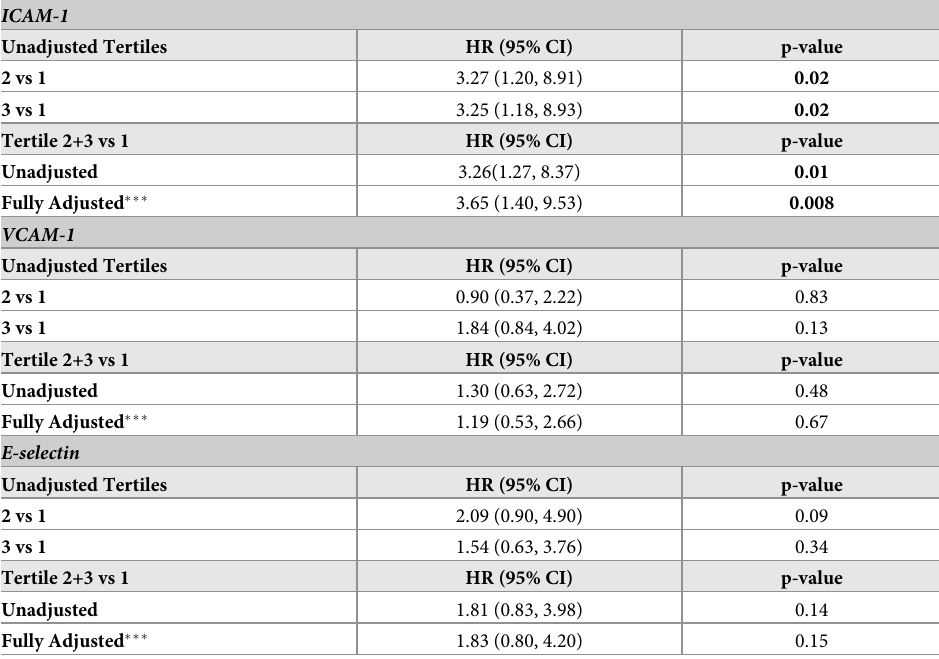
Table 3. Unadjusted and adjusted hazard ratios for adhesion molecule tertiles and cardiovascular